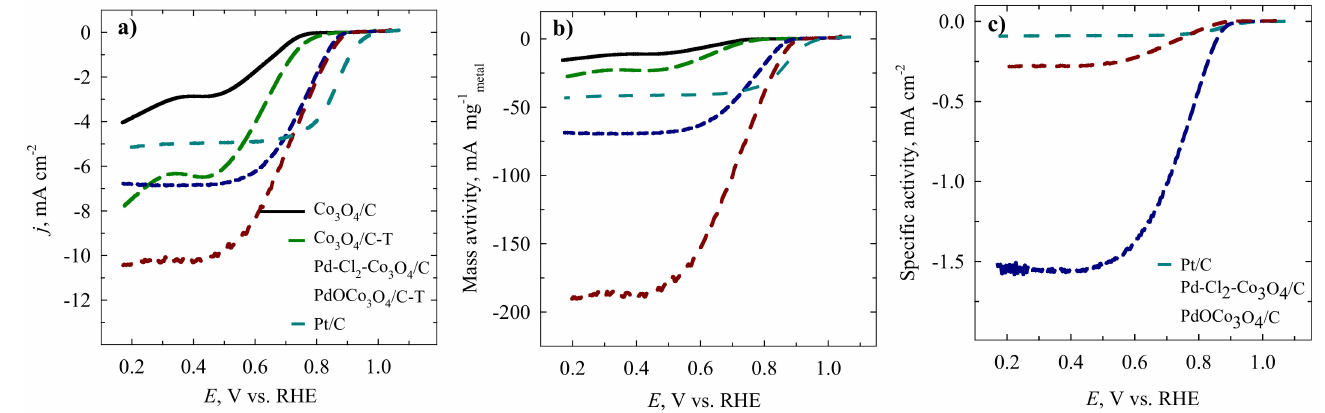
Figure 7. Comparison of ORR current densities at 1600 rpm in an O 2 -saturated 0.1 M NaOH solution ( a ), ORR current densities normalized by the metal loading ( b ), and ORR current normalized by the ESA values ( c ) for all investigated